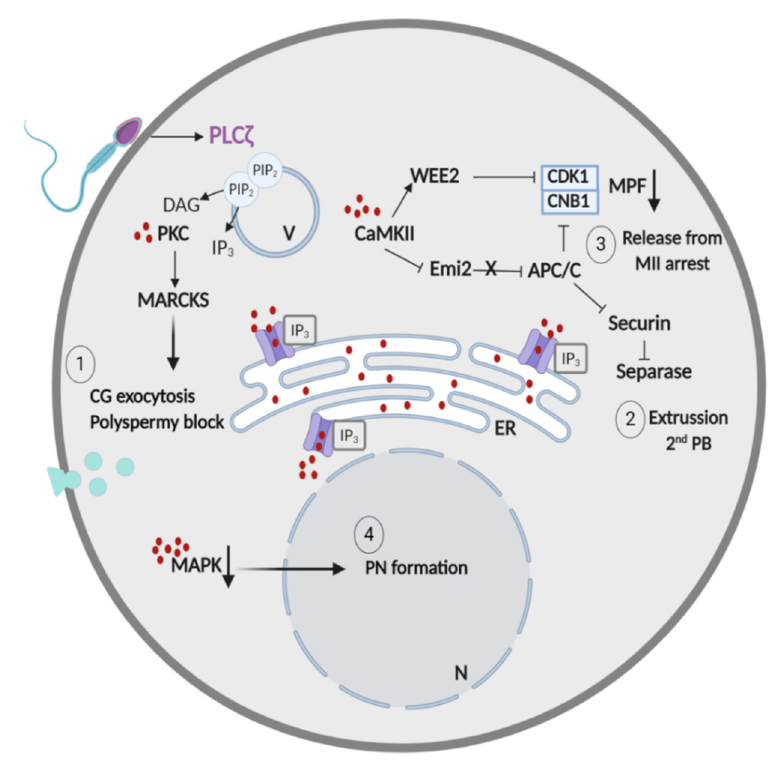
Figure 1. Oocyte activation pathway induced by the sperm factor PLC ζ . The release of sperm PLC ζ into the oocyte induces IP 3 production, which subsequently binds to its receptor (IP 3 R) and provokes Ca 2+ release from the endoplasmic reticulum. The Ca 2+ oscillations will activate different oocyte kinases in a time ‐ dependent order, allowing cortical granule exocytosis though PKC activation, extrusion of the second polar body and meiotic resumption via CaMKII activation and formation of pronuclei by MAPK inactivation. PLC ζ : phospholipase C zeta; DAG: